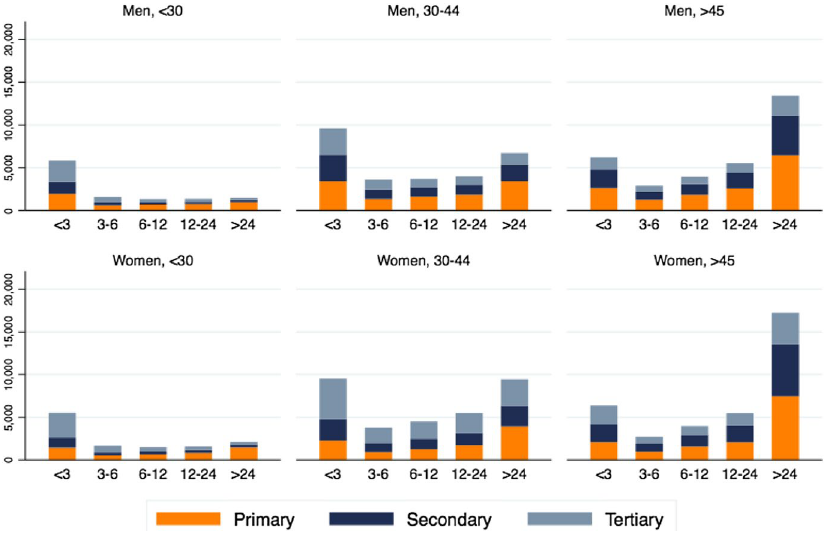
Fig. 2 Unemployed non-MIS recipients in the Basque Country, October 2015. Axes: gender, age, unem- ployment duration (months), educational level. Source : Own elaboration. Lanbide